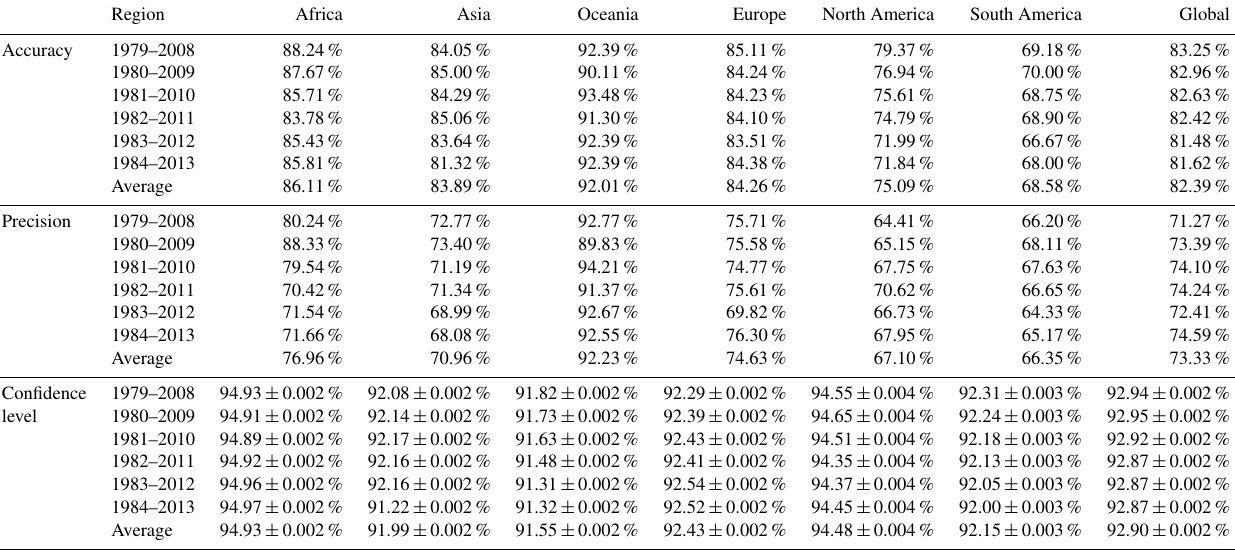
Table 3. Continental and global overall accuracy, average precision, and confidence level of the historical Köppen–Geiger climate map series climate classes using ground observations, and average precision is the averaged fraction of correct classification for all climate classes. Confidence level values show the 95% confidence interval of the confidence level for each continent and the whole globe. All the values are presented as percentages.